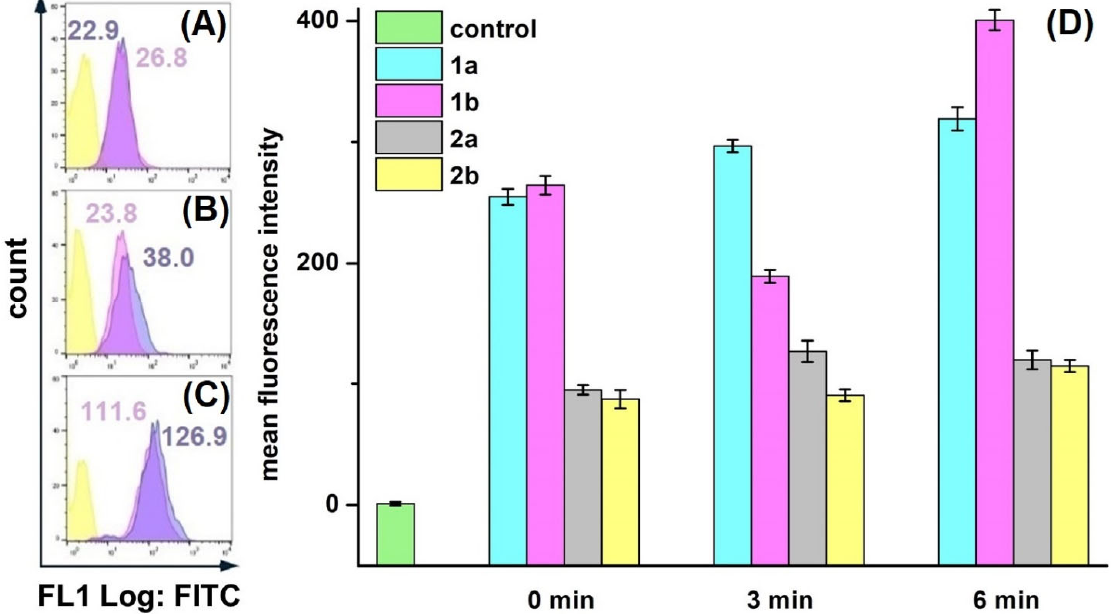
Figure 4. Different conditions of ROS registration in HeLa cells treated with XL ‐ 8 (100 nM; blue) and XL ‐ 8 ‐ NPs (100 nM; violet) (not treated cells; yellow) using DCFH ‐ DA. Fluorescent dye added: after harvesting cells ( A ), irradiation ( B ), and PS treatment ( C ). MFI of cells treated with XL ‐ 8 (blue numbers) and XL ‐ 8 ‐ NPs (violet numbers). Evaluation of ROS (1) and superoxide anion (2) levels in HeLa cells, treated with XL ‐ 8 (a) and XL ‐ 8 ‐ NPs (b) ( D ). HeLa cells displayed an intensive DCF green fluorescence after treatment with both formulations, followed by irradiation, evidencing the intracellular ROS formation. XL ‐ 8 demonstrated the strongest fluorescence intensity at 3 and 5 min after irradiation, indicat ‐ ing ROS level elevation. The XL ‐ 8 ‐ NPs induced the higher signal after 6 min, evidencing